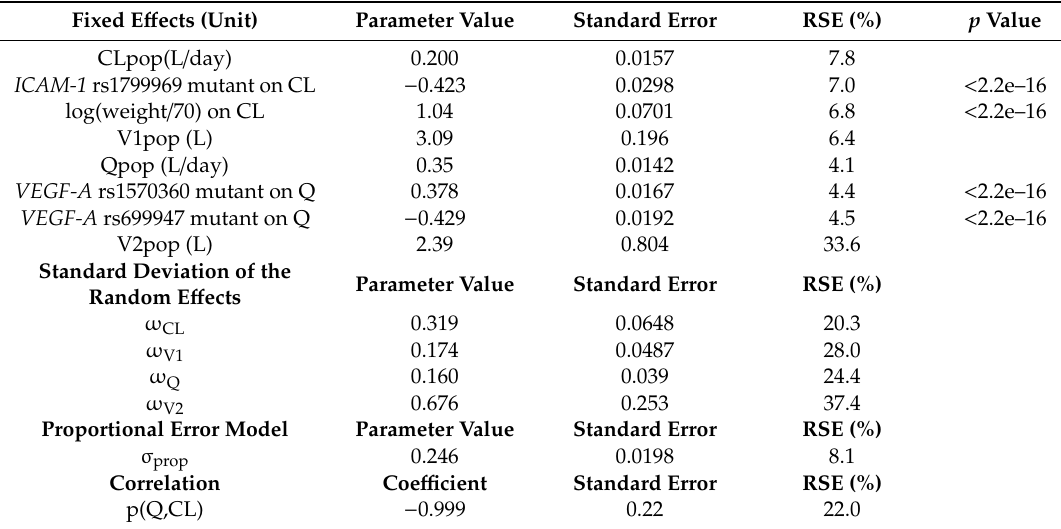
Table 1. Parameter estimates of the pharmacokinetic